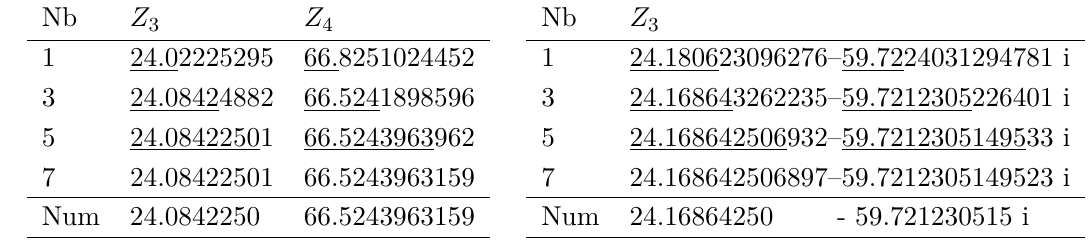
Table 6 . Left: the third and fourth spectral traces as computed from (D.5) for m = 0 , ~ = 1 , Λ = 1 e − 1 ( iπ ) . Right: the third spectral trace as computed from (D.5) for m = 1 / 20 , ~ = 1 , Λ = 1 6 5 We denote by Nb the order at which we truncate the NS partition function (6.1). The numerical result is obtained by numerical diagonalization of the operator